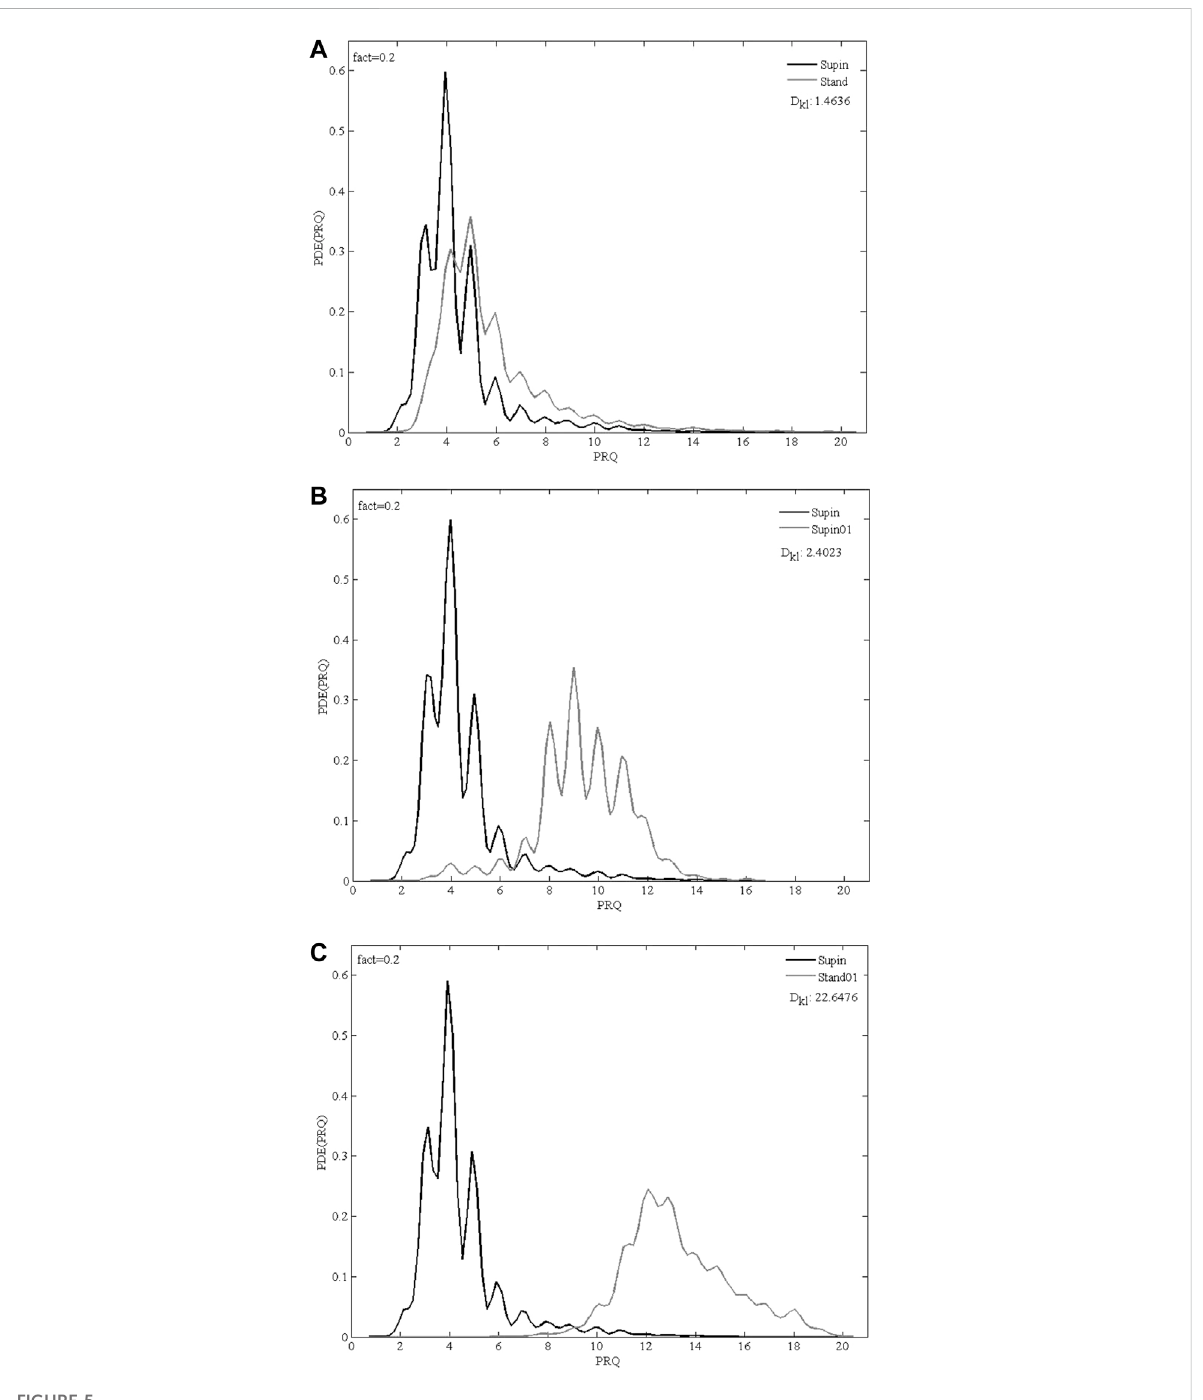
FIGURE 5 Overlapping PDE distribution pro fi les of PRQ parameter for 20 subjects in 3 comparison of physiological states: (A) Supin-Stand, (B) Supin- Supin01, (C) Supin-Stand01; Supin — supine position with spontaneous breathing, Stand — standing with spontaneous breathing, Supin01 — supine position with slow (0.1 Hz) breathing, Stand01 — standing with slow (0.1 Hz) breathing; fact — fi neness factor; DKL — Kullback-Leibler divergence (relative